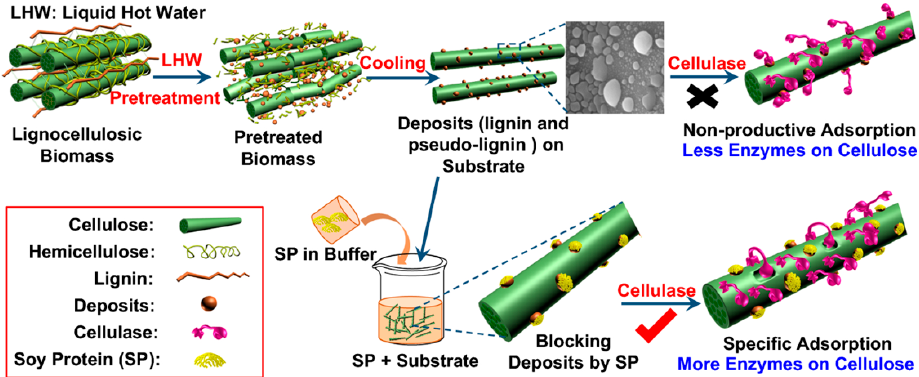
Figure 7. A proposed mechanism of the soy protein enhanced enzymatic hydrolysis of liquid hot water pretreated lignocellulosic biomass [45].